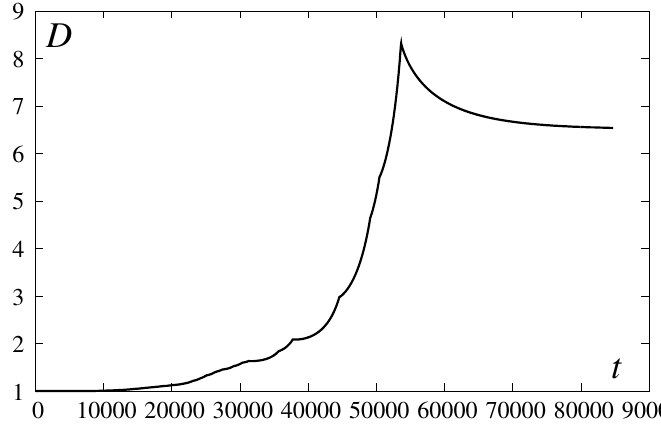
Figure 8. Flame speed D = Φ